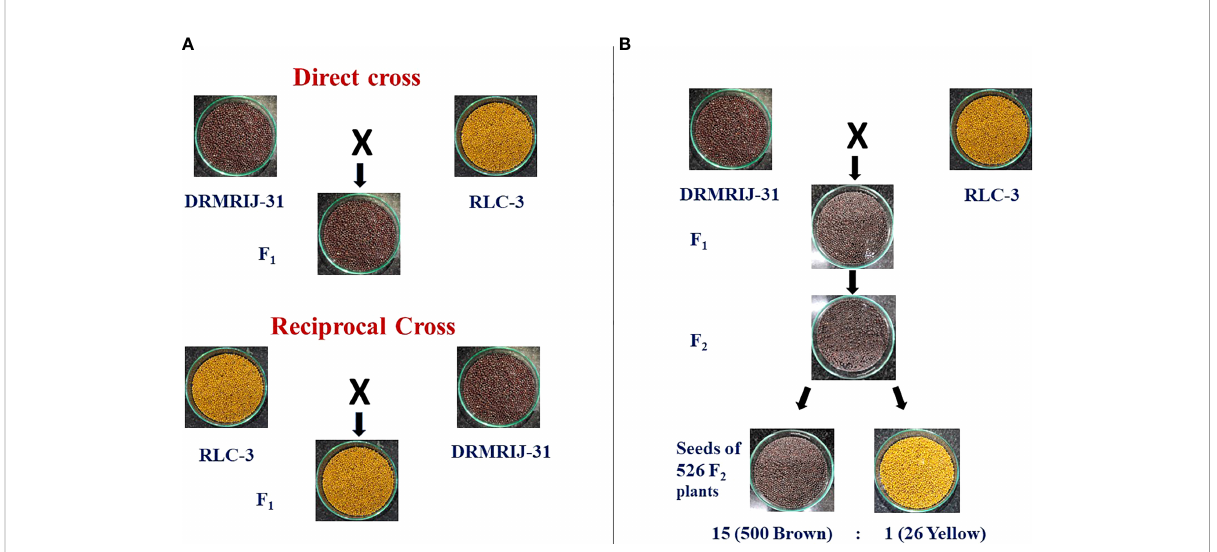
FIGURE 1 Inheritance pattern of seed coat colour (A) Seed coat colour differences in direct and reciprocal crosses of DRMRIJ-31 and RLC-3 (B) Duplicate dominant type segregation of seed coat colour in seeds of F 2